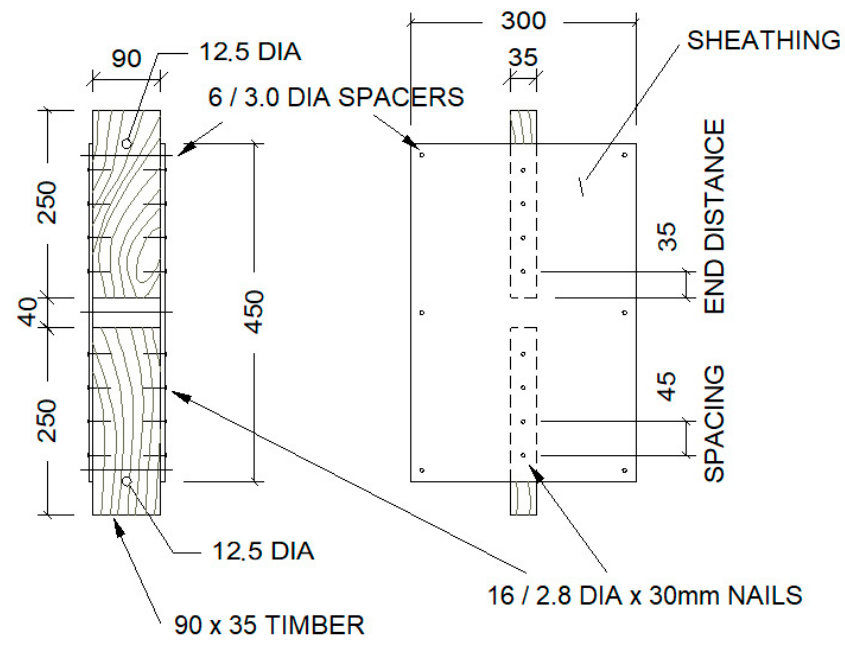
Figure 1. Typical small-scale test specimen (dimensions in mm).